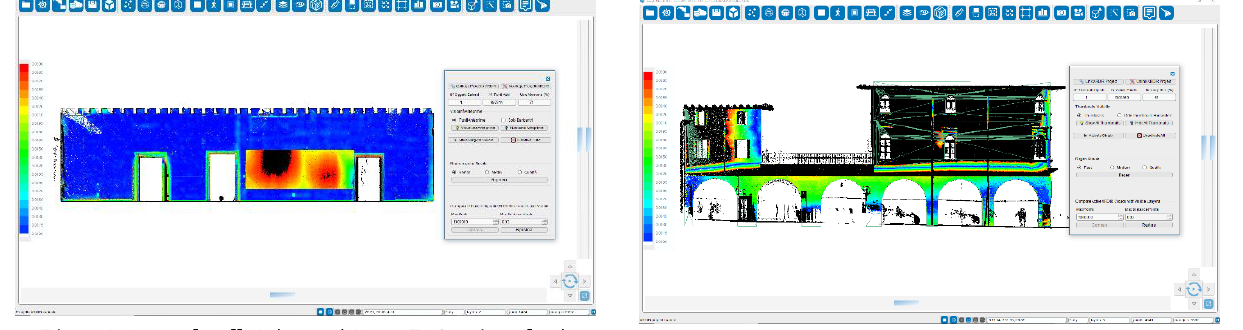
Figure 12. External wall: HBIM vs TLS points